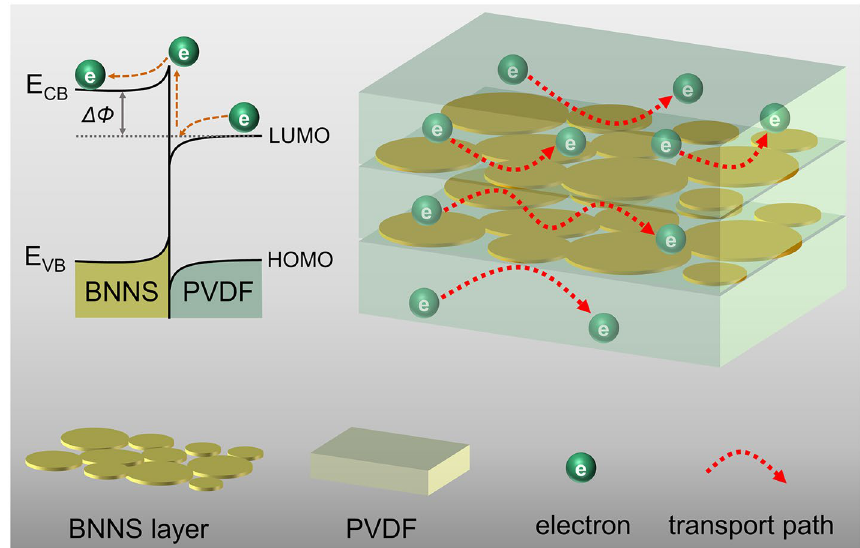
Fig. 6 Schematic illustration of restricted electron transportation in multilayered